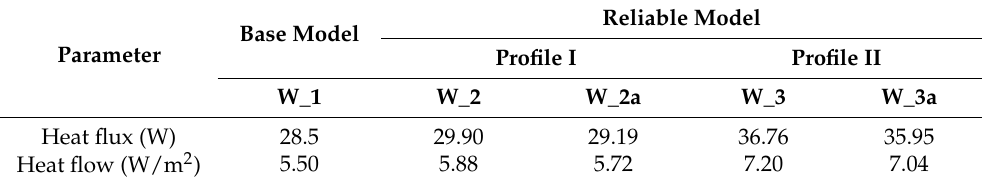
Table 4. Summary of the results of the numerical analysis for the wall–foundation system.